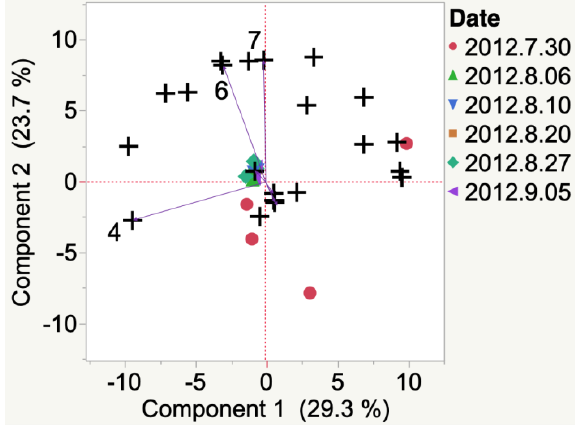
Figure 4. Evolution of VOCs emitted from whole clusters of 2012 Marquette grapes grown in South Dakota from veraison to harvest. Key to most representative volatiles from HCA, shown as vectors from the origin and read clockwise: 1 = 1-Hexadecanol, 2 = 2-Ethyl-1-hexanol, 3 = 1-Pentanol, 4 = Acetone, 5 = Indene, 6 = Decane, 7 = 4-Methyl-3-penten-2-one.